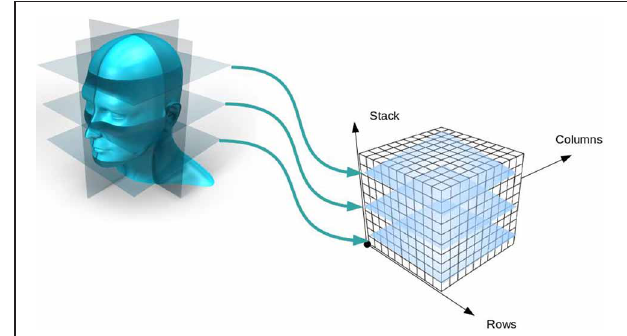
FIGURE 3 | Creation of an image volume. As two-dimensional image slices are acquired by a scanner, they are stacked together to form an image volume.